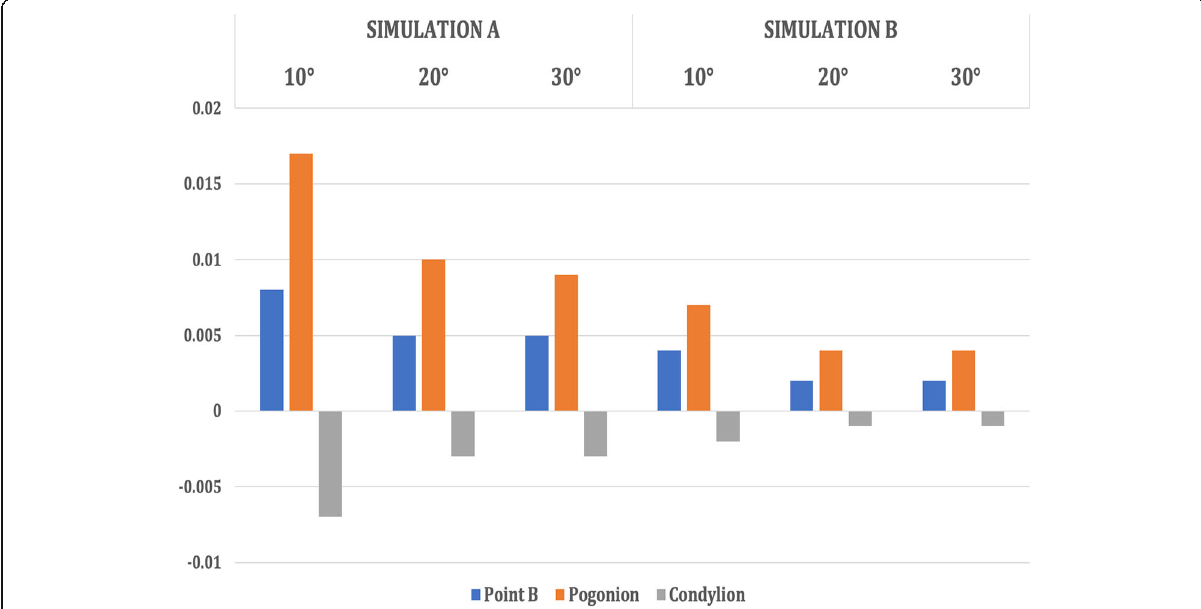
Fig. 8 Antero-posterior displacement of the mandibular landmarks when 250 g of force was applied at the three angulations (10° to